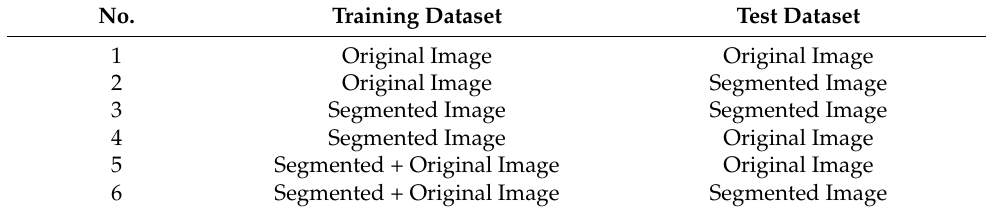
Figure 8. Dimensionality-reduction visualization results for datasets. ( a ) Original nonviolence, ( b ) Segmented nonviolence, ( c ) Original violence, ( d ) Segmented violence. Table 2. Comparative experiment